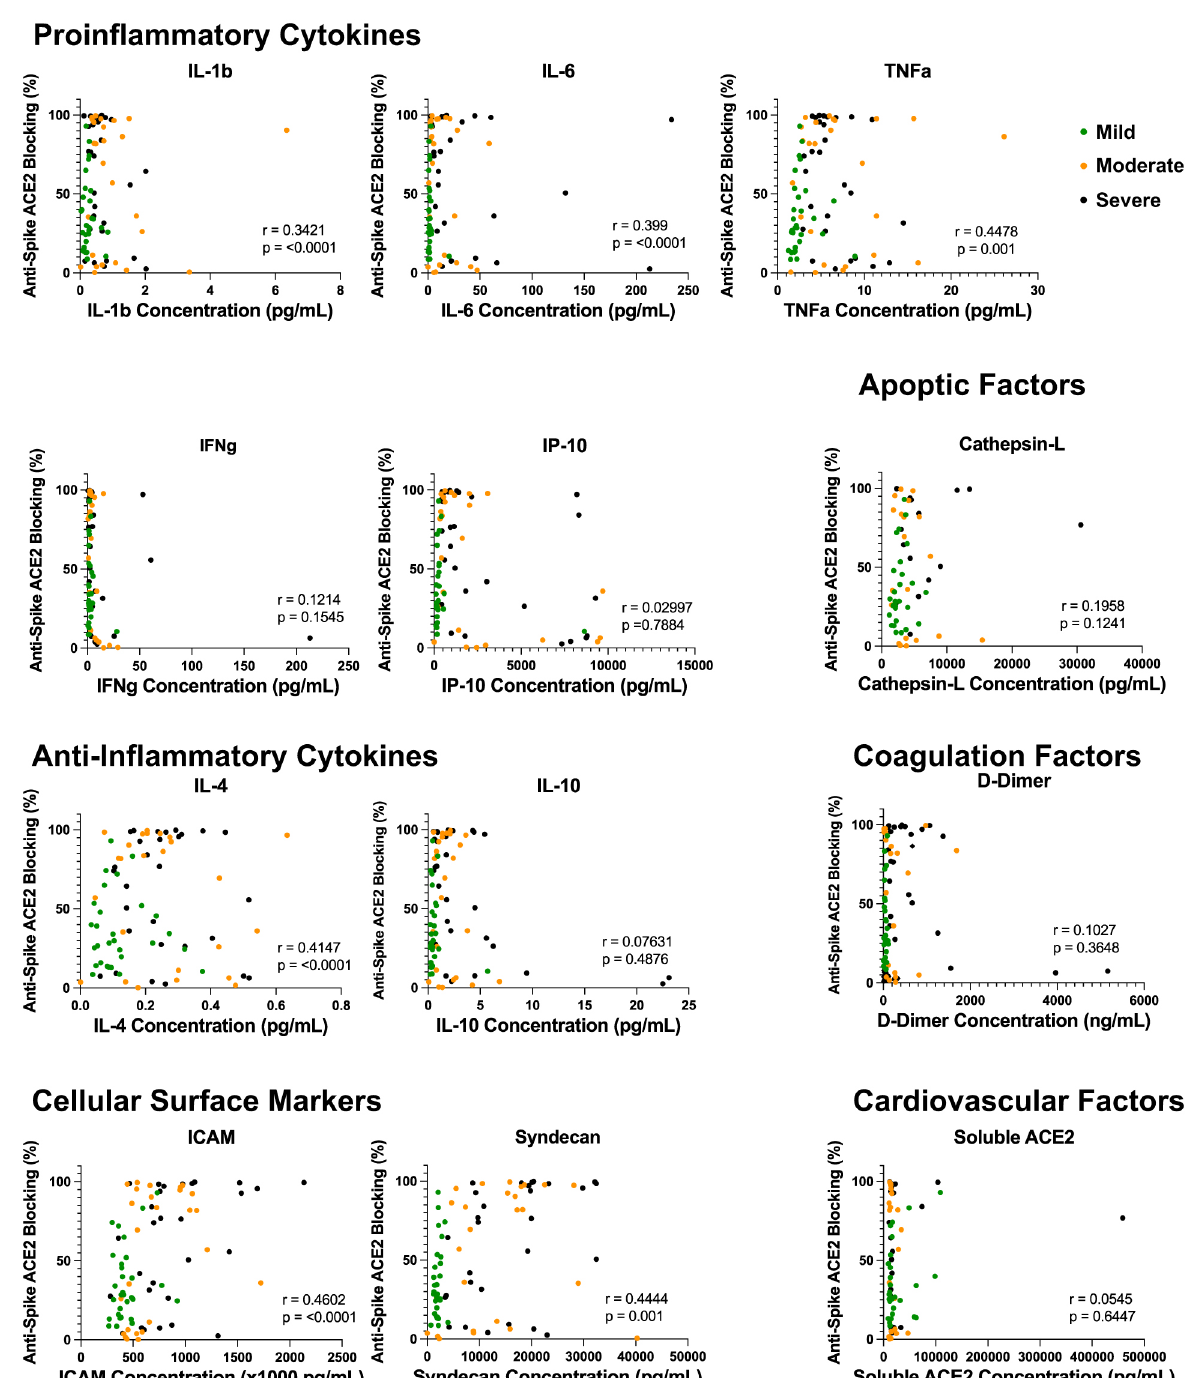
Figure 5. Proinflammatory dysregulation between cytokine microenvironment and antibody neutralization capacity. Correlation analysis of inflammatory marker plasma concentration and anti-spike antibody ACE2 neutralization disease severity. Elevations in ICAM ( P < 0.0001), IL-1β ( P = 0.0233), IL-4 ( P < 0.0001), IL-6 ( P = 0.0001), TNFα ( P = 0.001), and Syndecan ( P = 0.00) all showed statistically significant correlations to antibody neutralization capacity amongst PCR-positive COVID-19 disease